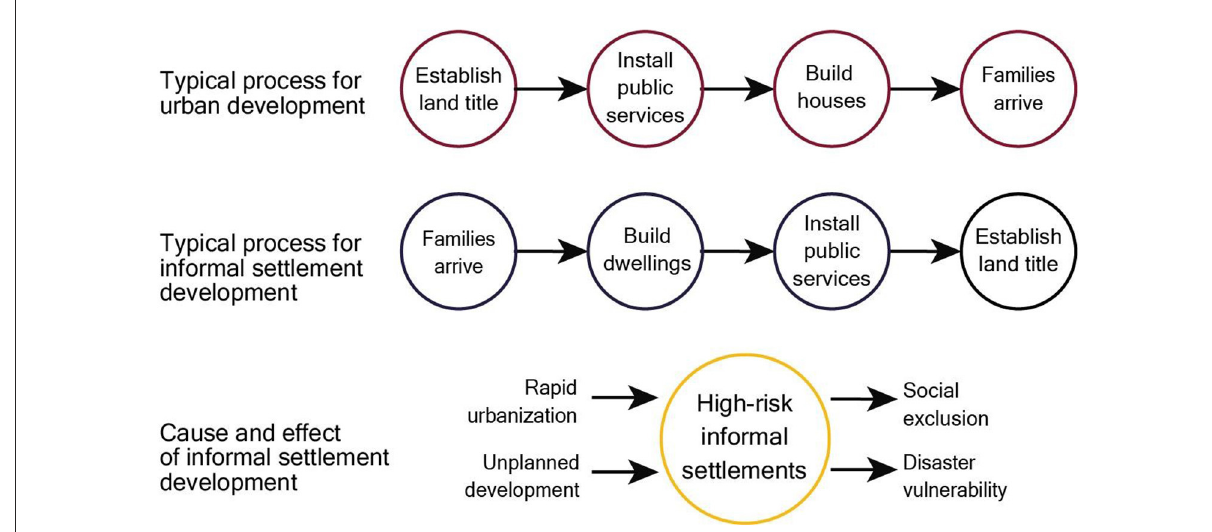
FIGURE1 Conceptual process for the contributions of informal settlement development to disaster vulnerability. Adapted from GOAL’s Resilient and Inclusive Neighborhood Approach (RINA)